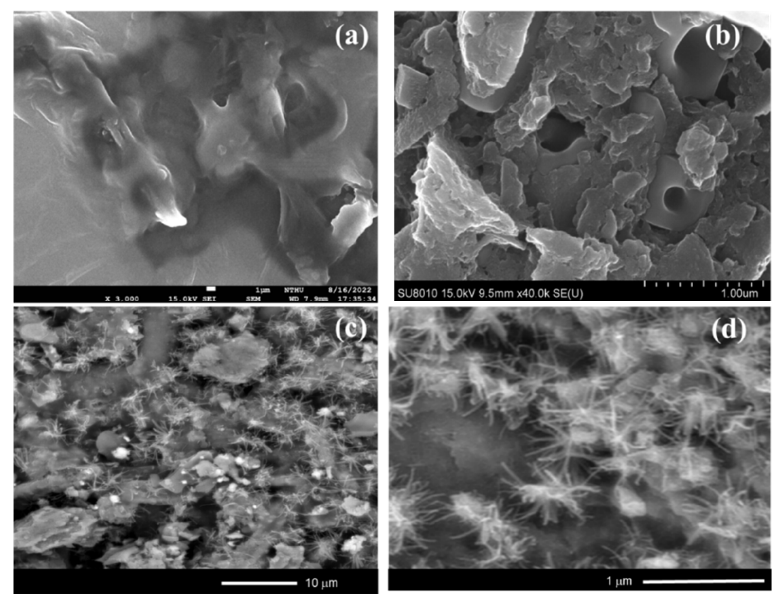
Figure 2. SEM images of ( a , b ) BC and ( c , d ) Ni/BC in different magnifications. The occurrence of the Ni NPs in the Ni/BC nanocomposite is strengthened by the TEM and HRTEM images presented in Figure 3. Figure 3a shows the heterogeneous forms of the particles with a highlighted nanowires-like structure, in line and associated with the structures identified by the SEM image. In higher magnification (Figure 3b), the nanowires’ structures are clearly identified. Moreover, by HRTEM analysis, the fringes of Ni NPs are expressed with a distance of 0.21 nm (Figure 3c). These fringes space are associated with (111) reflections of Ni nanoparticles [27]. Based on the heterogeneous spherical particles, particles size distribution is as presented in Figure 3d, and it can be concluded that the particle size ranges from 30–50 nm.